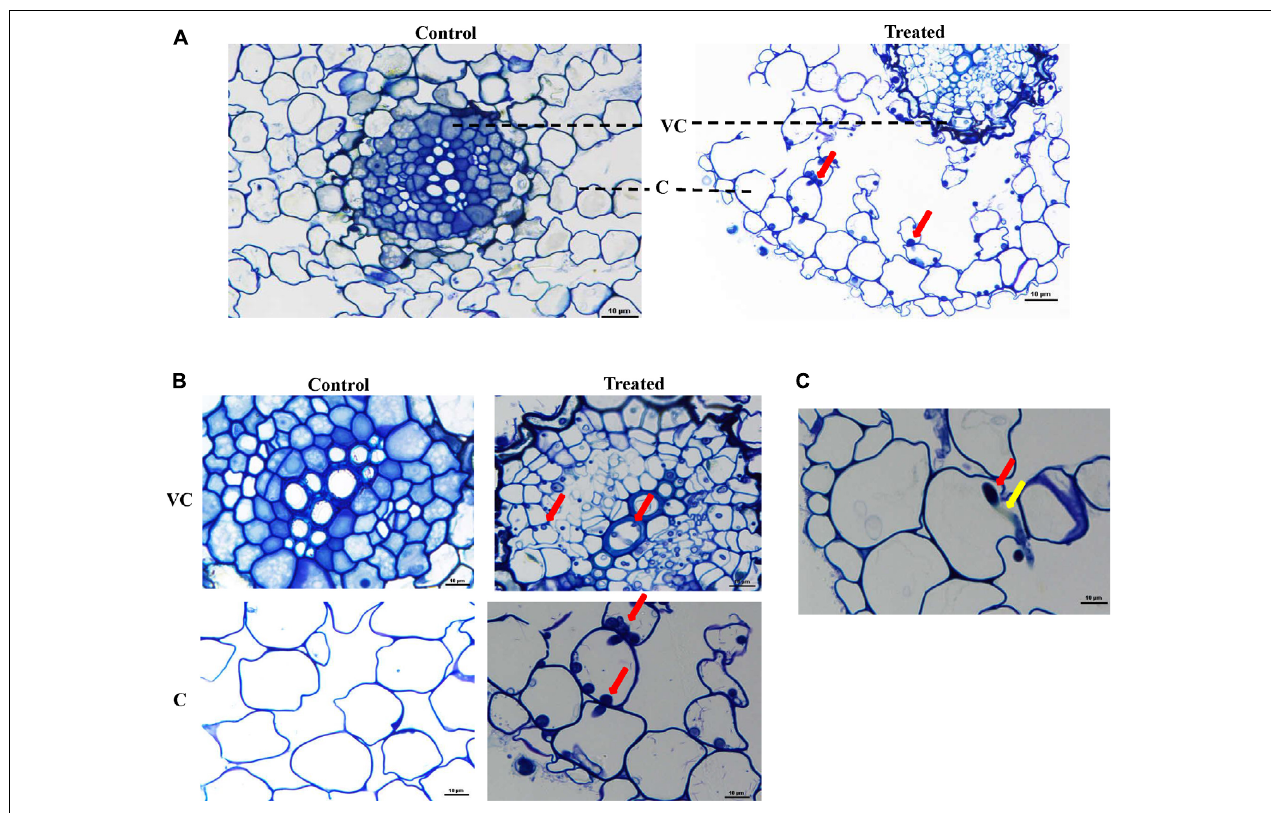
FIGURE 3 | Micromonospora chalcea UAE1 colonizes the root tissues of Salicornia bigelovii. Light micrograph of semi-thin sections of a 2-week-old S. bigelovii root (A) not inoculated (control; left) or inoculated with M. chalcea UAE1 (treated; right) (400 × ); (B) close-up views of vascular cambium and cortex of S. bigelovii root inoculated with M. chalcea UAE1 (1000 × ); and (C) mycelial growth of M. chalcea UAE1 carrying spores penetrating S. bigelovii root cortex cells (1000 × ). In (A–C) , all sections were stained with 0.1% toluidine blue showing the distribution of spores (red arrows) and substrate mycelium (yellow arrows) within the roots cells of S. bigelovii . Bars: 10 µ m. VC, vascular cambium; C,